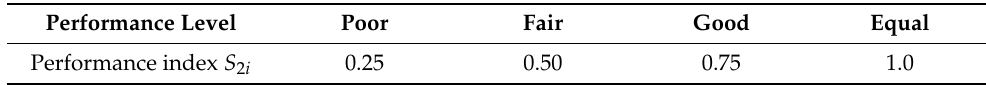
Table 5. Performance evaluation